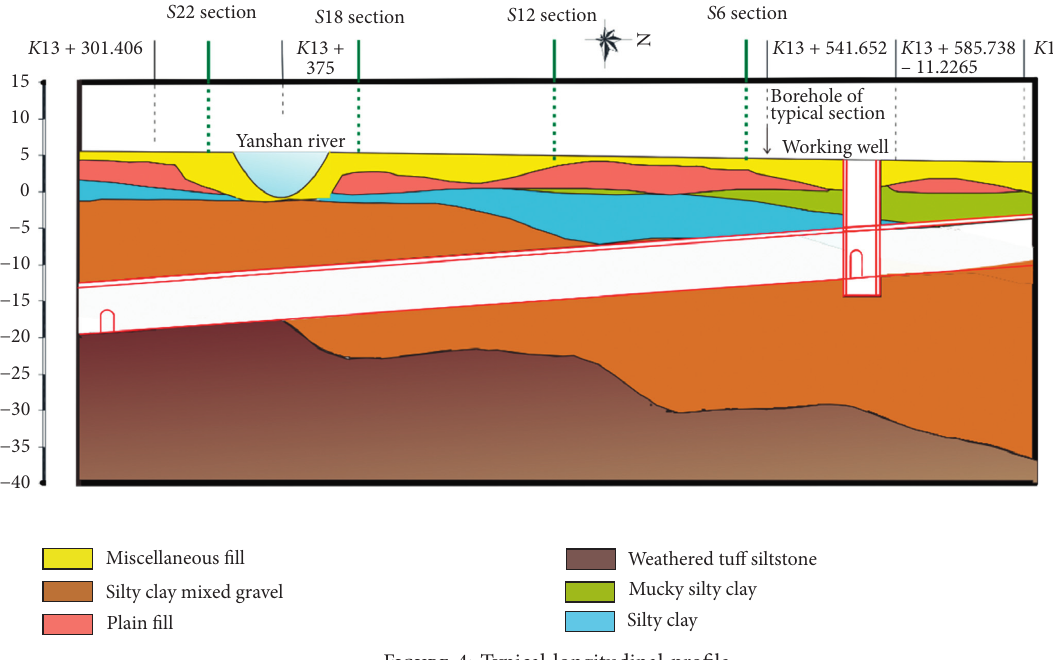
Figure 4: Typical longitudinal profile.